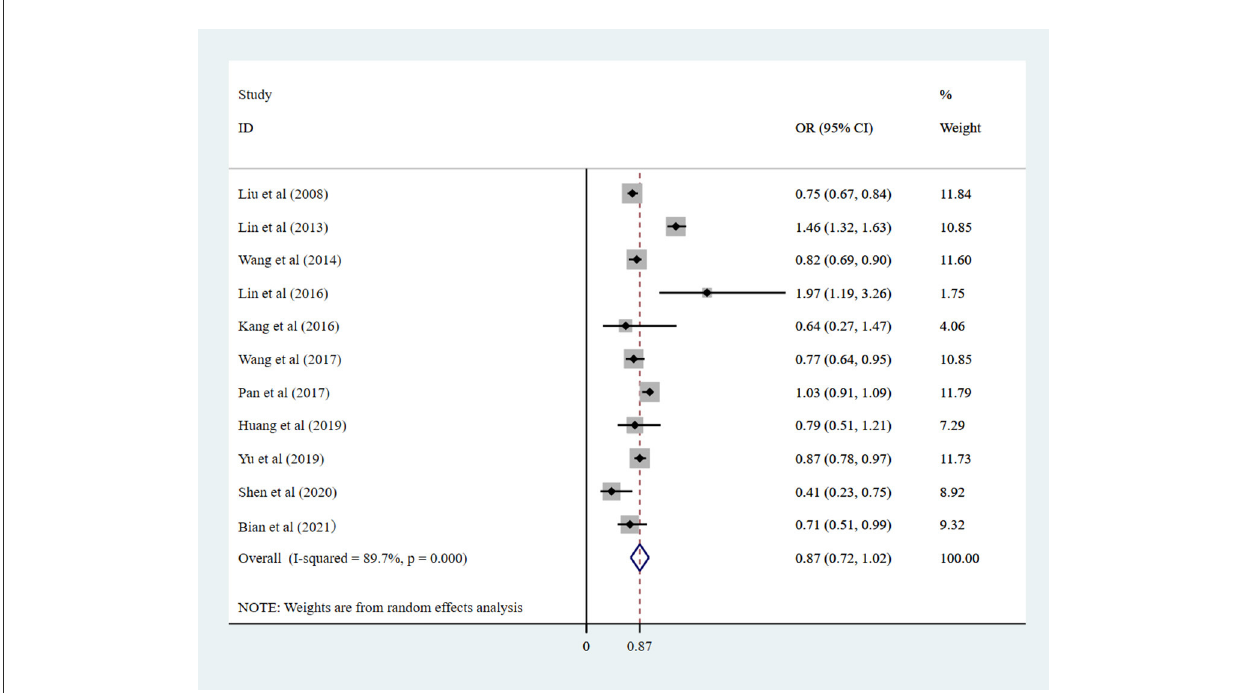
FIGURE2 Randomized effect meta-analysis investigating the correlation between eye exercises and myopia in children and adolescents in multivariate analysis. CI, confidence interval; OR, odds ratio.